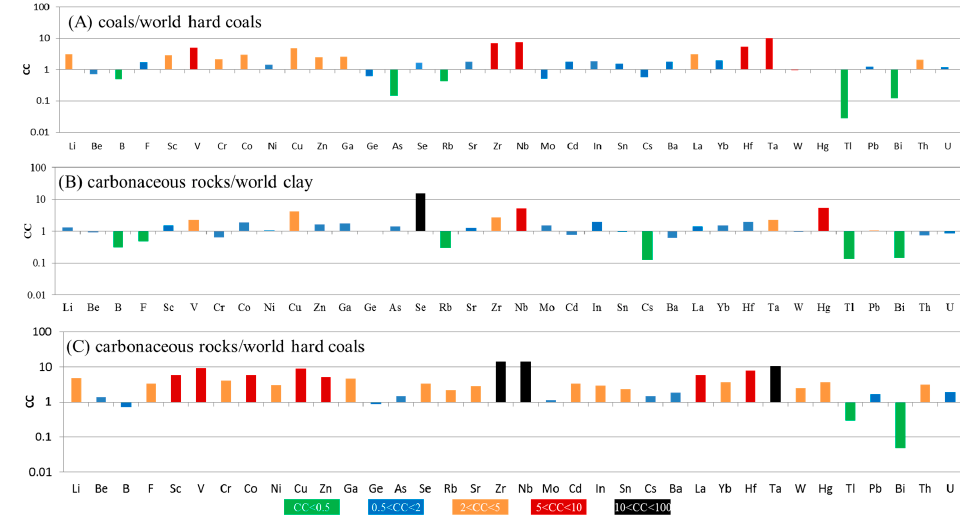
Figure 3. Concentration coefficient (CC) of trace elements in average Shugentian coal ( A ) and carbonaceous rock benches ( B , C ), Normalized by trace element concentrations in the world hard coals [66] and world clay [67].